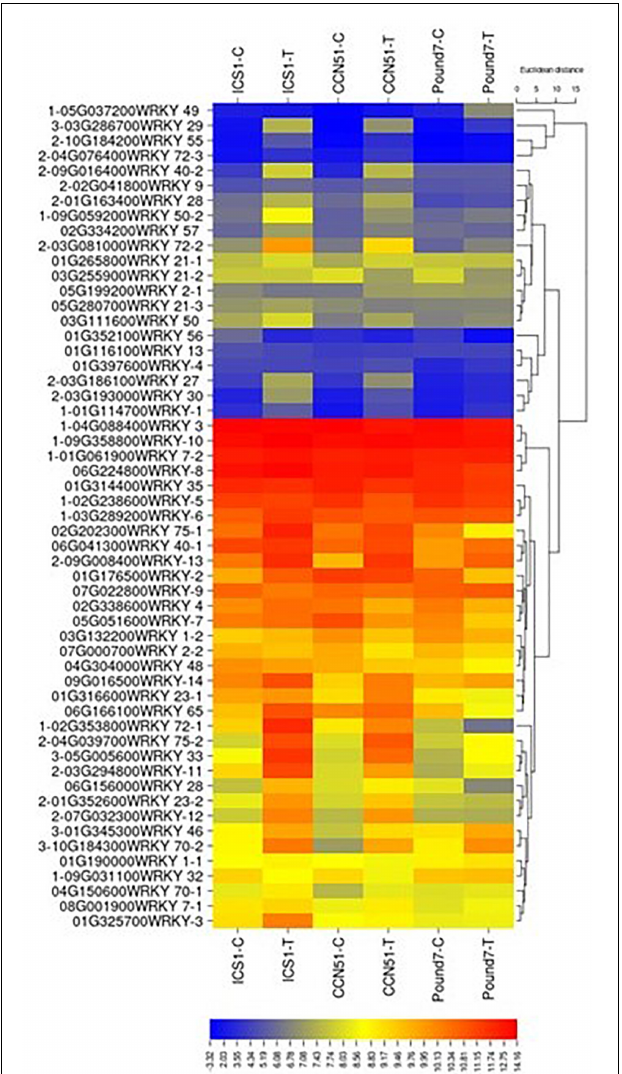
FIGURE 5 | A heat map displaying relative expression levels of cacao gene, putatively encoding WRKY-related proteins in young red leaves of ICS1, CCN51, and Pound7 24 h after inoculation with 20- µ l drops of zoospores (0.6 × 10 5 zoospores/ml). All genes with at least 5 base mean reads are included. Initial numbers indicate the number of genotypes with significant differential expression between treated and control samples and where missing indicates no differential expression. The following – and _, indicate upregulated and downregulated genes, respectively. The following numbers represent gene identifications in the cacao transcriptome ( Supplementary Data Sheet 1 ). The following text identifies putative WRKY identity.